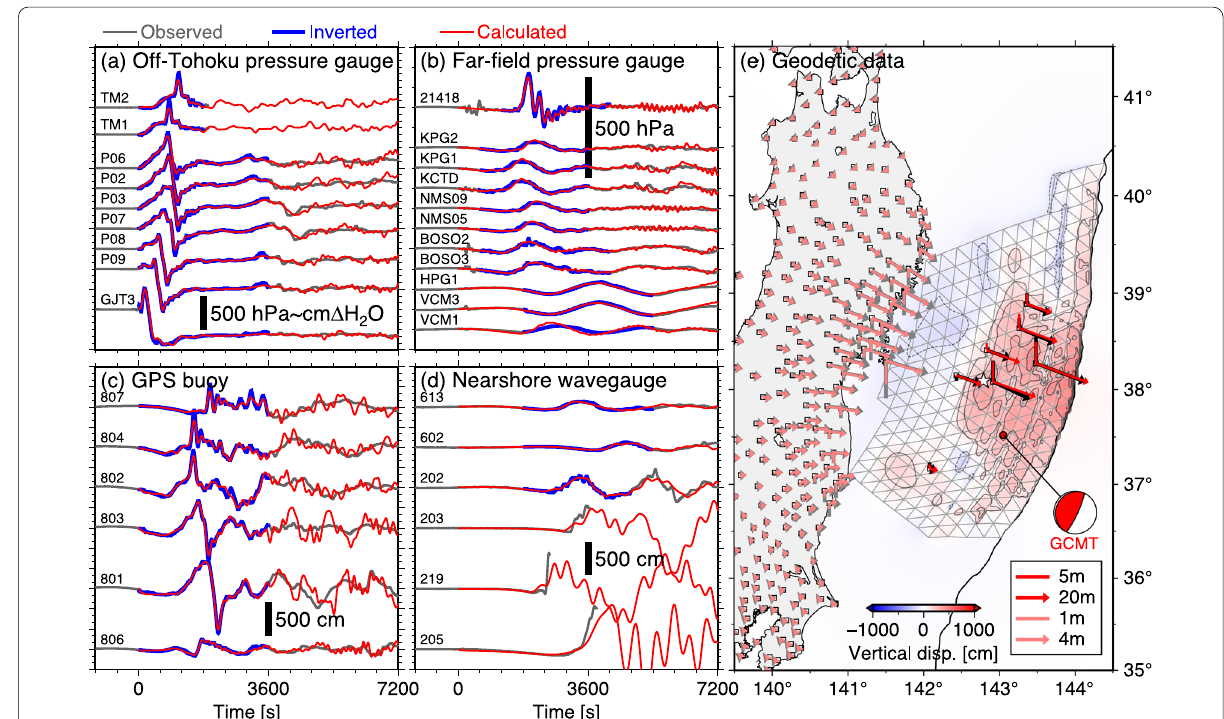
Fig. 6 Comparison between the observed and synthetic data. a – d Comparisons of the seafloor pressure gauge waveforms above the focal area, the far-field seafloor pressure gauge waveforms, the offshore GPS buoy waveforms, and the nearshore wave gauge waveforms near the coast. Gray and red waveforms are the observed and synthetic waveforms, respectively. Blue lines indicate the time window used for the analysis. Locations of each station are shown in Fig. 1. e A comparison of the observed and synthetic data of the geodetic dataset. Black and gray bars and arrows denote the observed movement of the offshore and onshore geodetic stations. Light and dark red bars and arrows are the synthetic ones. Note that the length of the bars and arrows differs between the onshore and offshore stations. The distribution of the seafloor vertical displacement calculated from the fault model is also